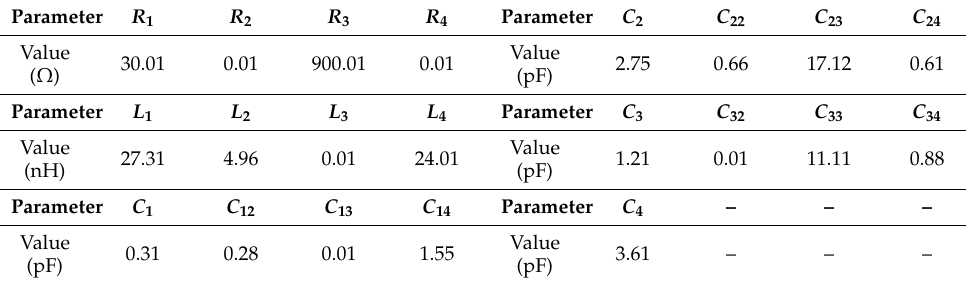
Table 2. Optimized parameter value of the equivalent circuit model.